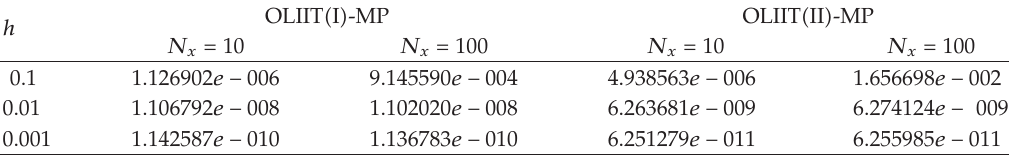
Table 6: The errors (cid:16) at t (cid:5) 10 when the algorithms are applied to the problem (cid:3) 5.6 (cid:4) with the coe ffi cients group II, where τ (cid:3) t (cid:4) (cid:5) sin t (cid:8)